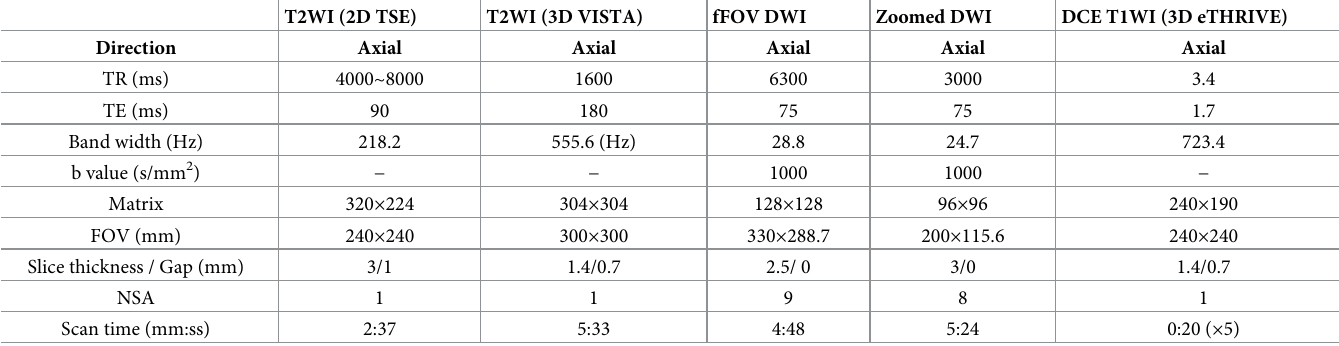
Table 1. MRI protocol of the bladder